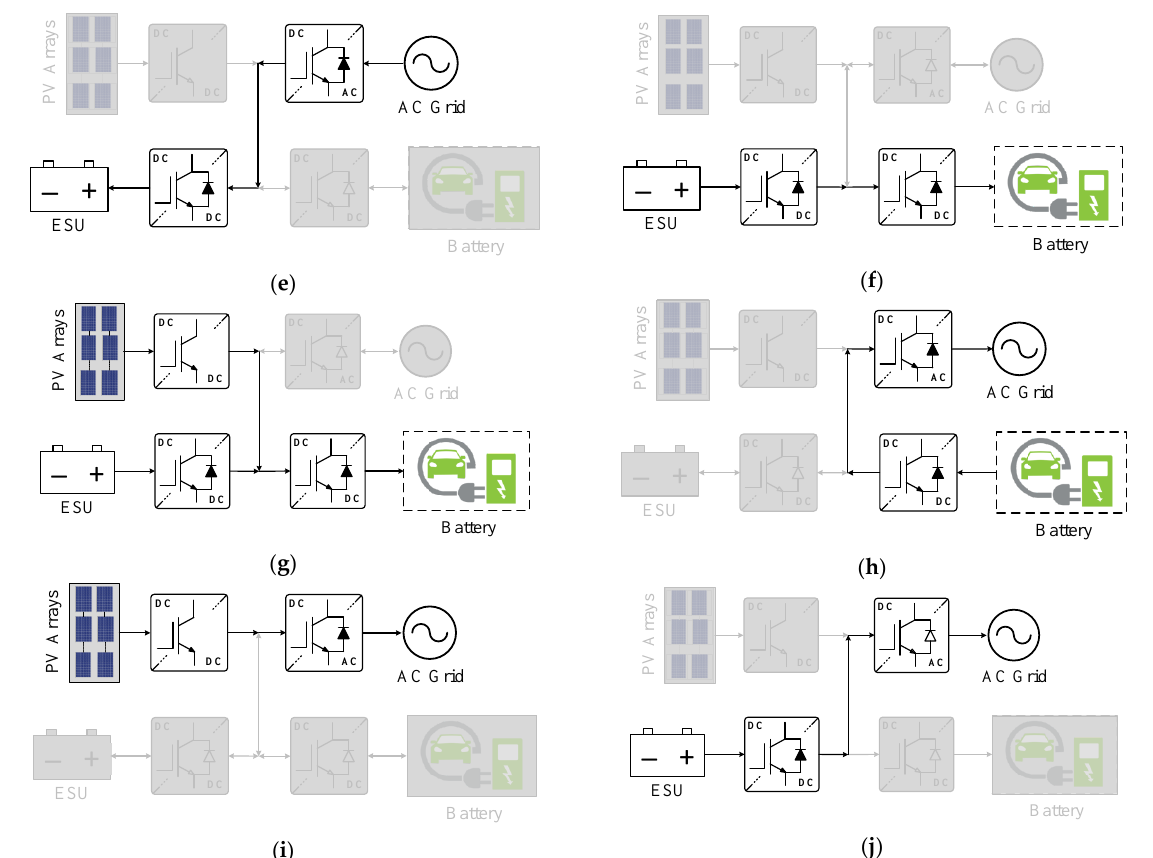
Figure 4. Operating modes of PV-grid charging system: ( a ) Mode 1: PV-to-EV, ( b ) Mode 2: Grid-to- EV, ( c ) Mode 3: PV and grid-to-EV, ( d ) Mode 4: PV-to-ESU, ( e ) Mode 5: Grid-to-ESU, ( f ) Mode 6: ESU-to-EV, ( g ) Mode 7: PV and ESU-to-EV, ( h ) Mode 8: EV-to-grid (V2G), ( i ) Mode 9: PV-to-grid, and ( j ) Mode 10: ESU-to-grid.